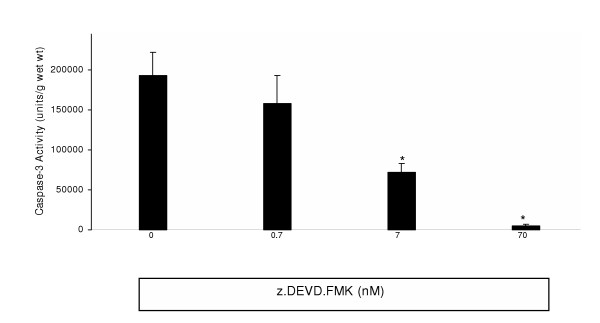
Dose-response effect of the caspase-3 inhibitor z.DEVD.FMK on caspase-3 activitiy of atrial muscles subjected to 90 minutes of simulated ischaemia followed by 120 minutes of reoxygenation. Data are expressed as the mean of 4 experiments and the bars represent the SEM. *p < 0.05 vs group without inhibitor.